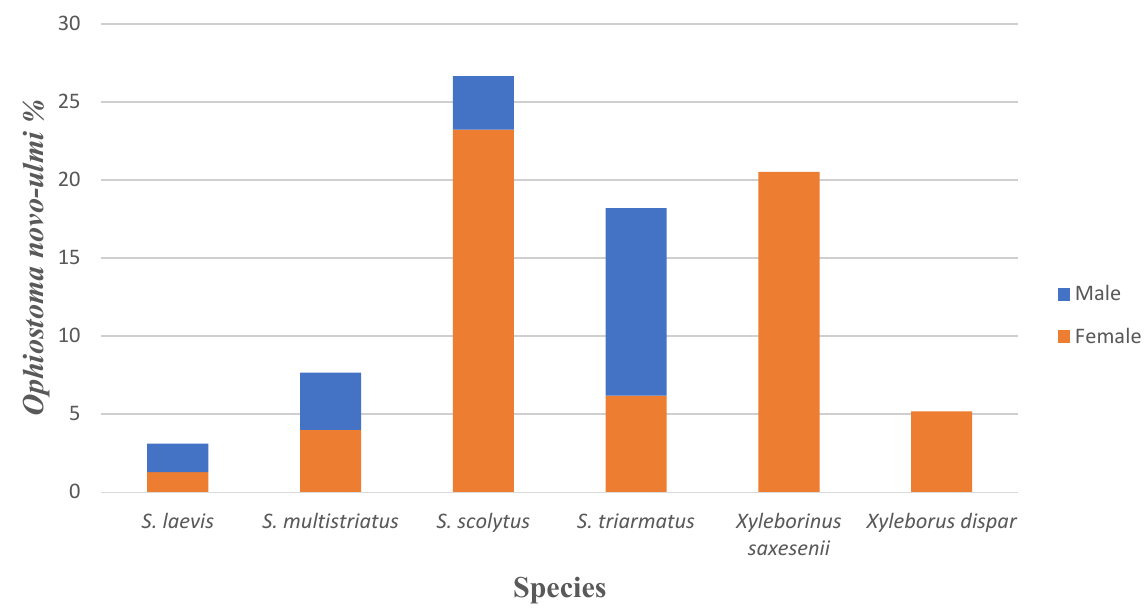
Figure 2. Percentage of O. novo-ulmi across different beetle species and gender (N = 109). No O. novo-ulmi was found on S. pygmaeus.